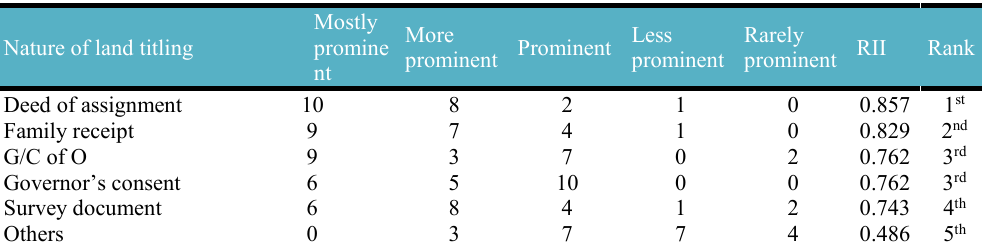
Table 3. Nature of Land Titling Securing Speculated Land